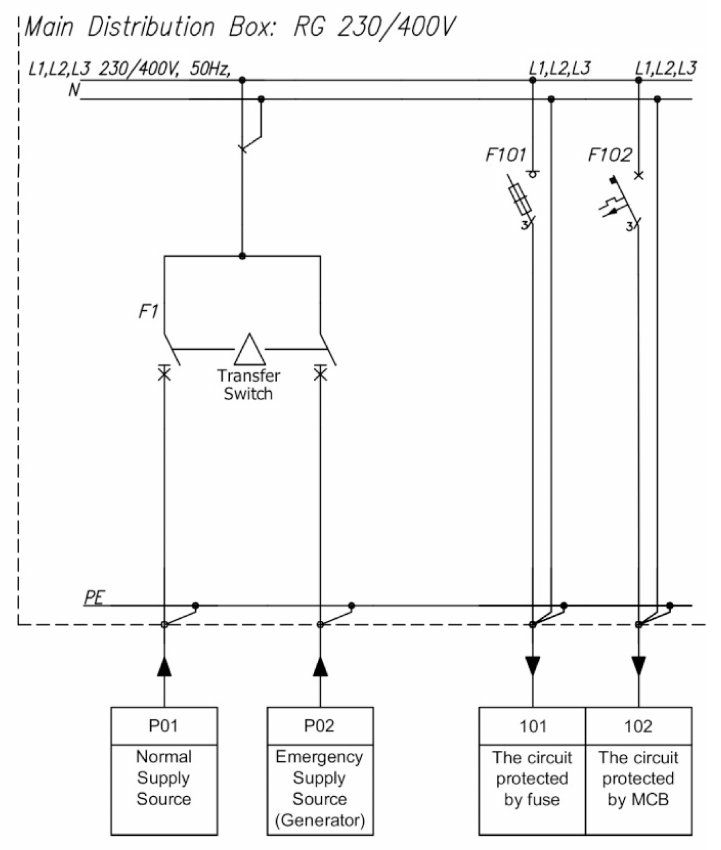
Figure 1. Distribution Box (DB) circuit